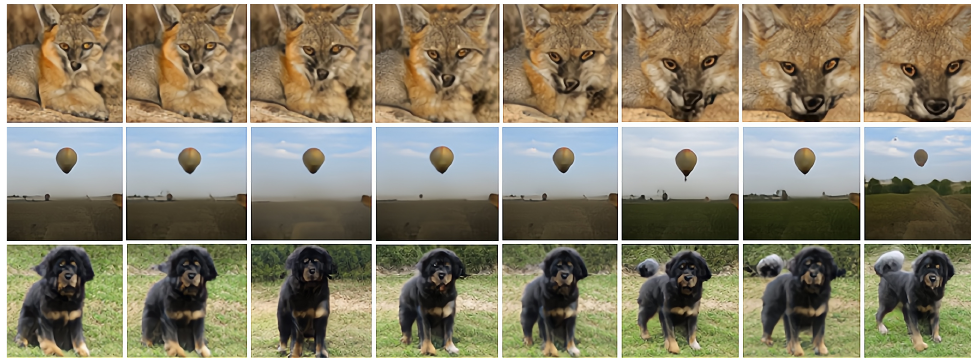
Figure 5. The orthogonal orientation learned on BigGAN [2].